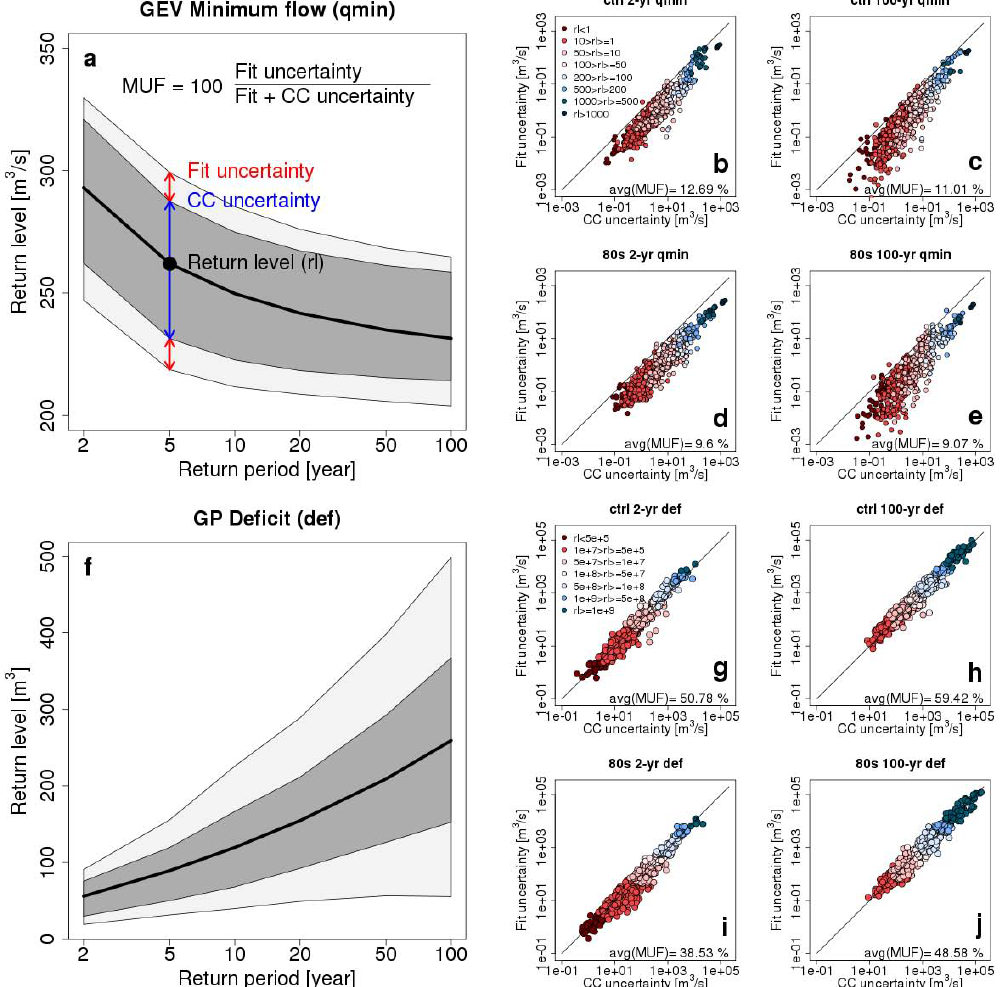
Fig. 13. Relationship between the magnitude of climate change (CC) and EV fitting (Fit) uncertainties over the 446 gauging stations (see Fig. 1) for the control and 2080s periods and for the 2 and 100yr return periods. Colors of points refer to the magnitude of return levels (rl). GEV results for minimum flows shown in panels (a) through (e) , while GP results shown in panels (f) through (j)